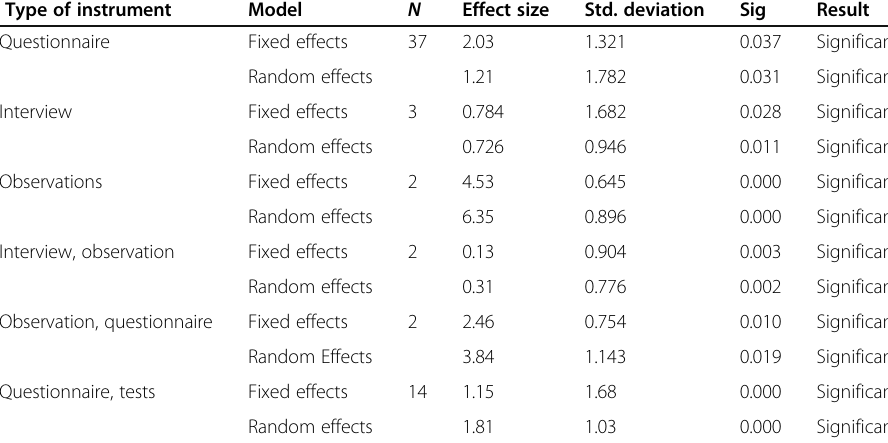
Table 10 Effect size by